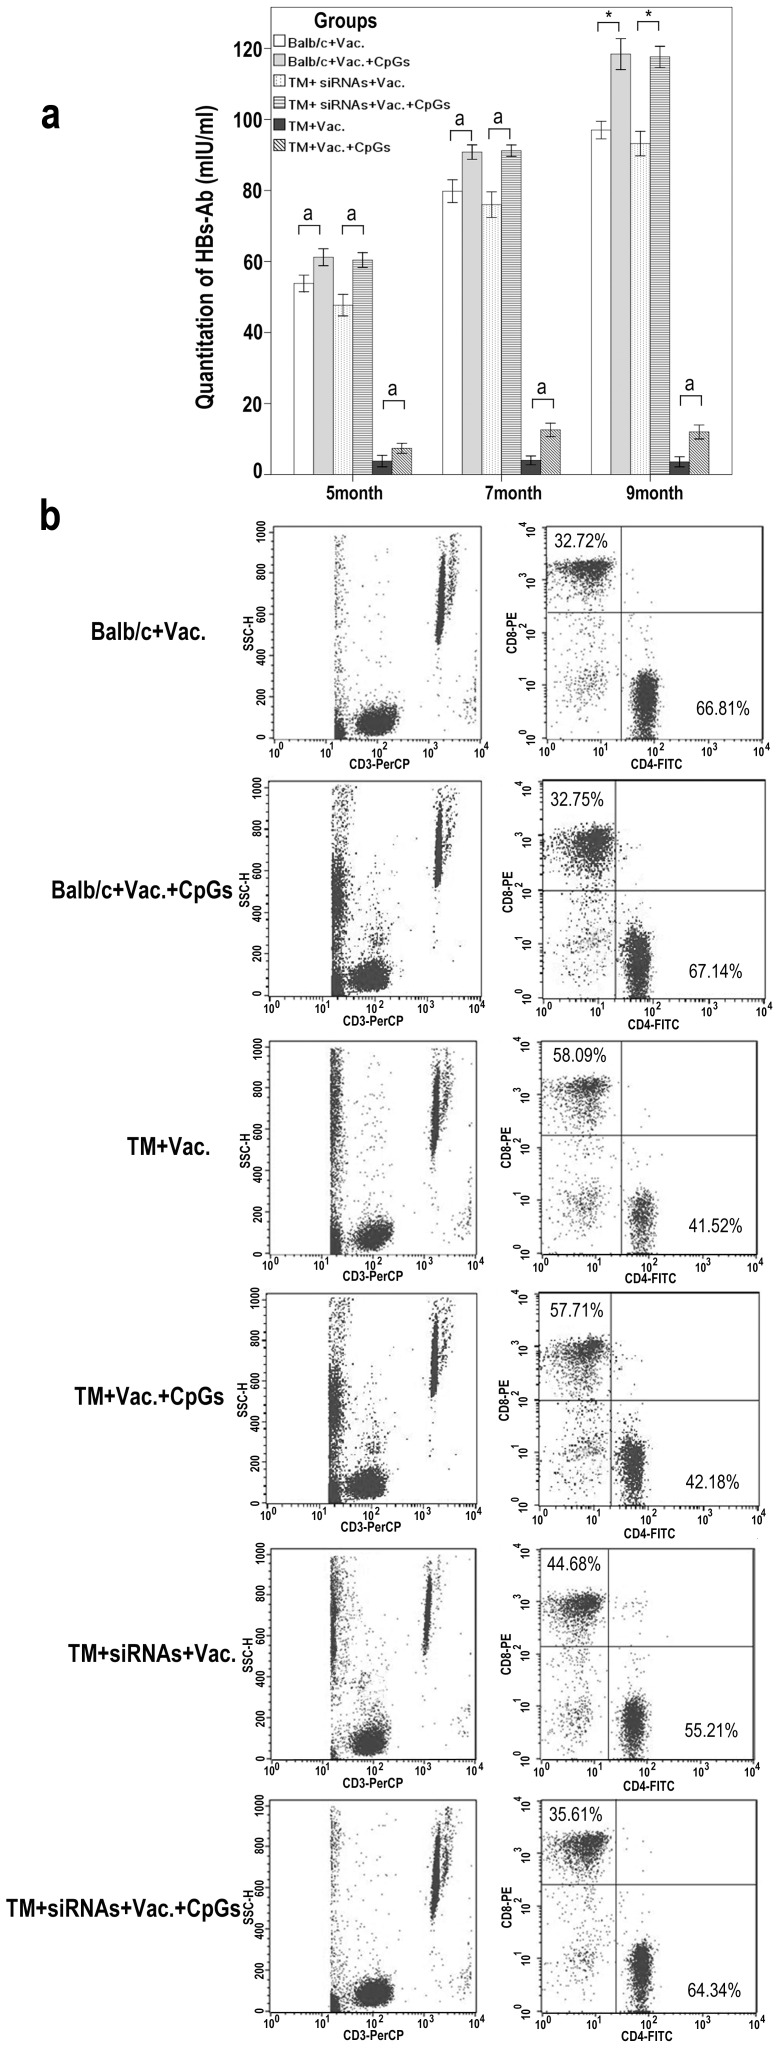
CpG ODNs enhance adaptive immunity after HBV vaccination.HBsAg-Ab quantification was carried out using microparticle enzyme immunoassay (MEIA) at 5-, 7-, 9-month following the first vaccination. Compared to controls, the CpG ODNs raised the level of HBsAg-Ab in the serum of transgenic mice after three injections of HBV vaccine (a). The mononuclear cells were stained with CD3, CD4 and CD8 specific abs. CD3 gated cells were examined for CD4 and CD8 expression. The percentage of CD4+ and CD8+ T cells sorted by flow cytometry in the livers of CpG ODN vaccine co-injection group were identical to Balb/c mice with vaccine only (b). The symbol ‘a’ above the brackets indicate no differences between two groups. n = 8 mice per group. Balb/c mice, normal mice; Vac., vaccination; TM, transgenic mice; siRNAs, pSilencer4.1-C2. (*: p<0.05, a: p>0.05).